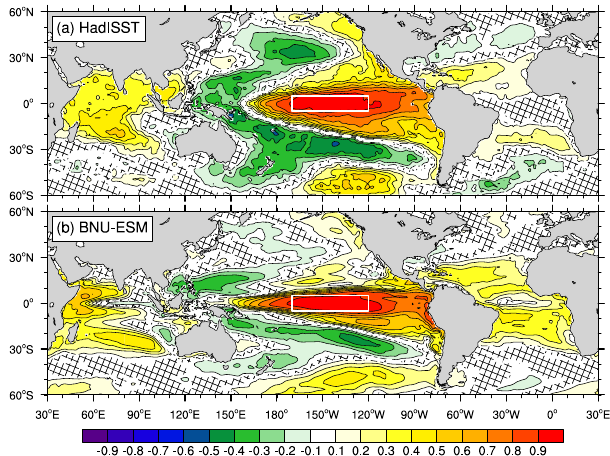
Figure 19. Correlation of monthly mean Niño-3.4 SST anoma- lies with global SST anomalies for the HadISST and BNU-ESM. The anomalies are found by subtracting the monthly means for the whole time series that span the years 1900–2005. Hatched area in- dicates regions where the correlation is not significantly different from zero at the 95% confidence level.